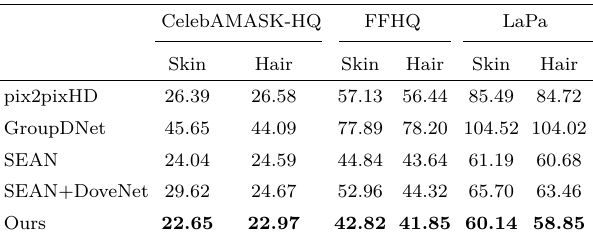
Table 2 FID ↓ results for skin and hair transfer